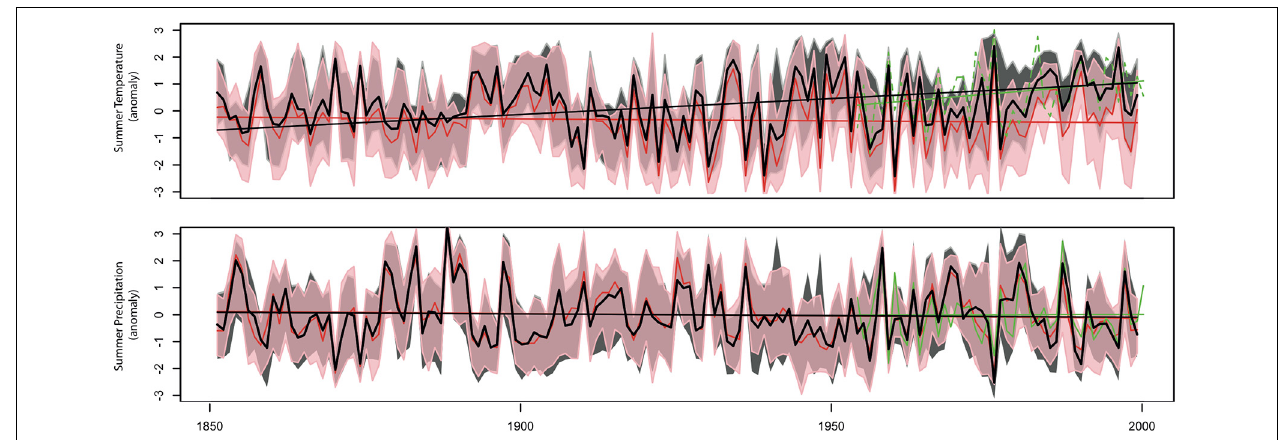
intervals) are median reconstructed values obtained when the inversion is forced by CO 2 concentrations fixed at pre-industrial levels (280ppmv). The dashedgreenlinerepresentsobservedclimateseries(1953–1999).Linearlines with corresponding colors were added to each series to evaluate linear trends in reconstructed and observed climates. Adapted from Boucher et al.